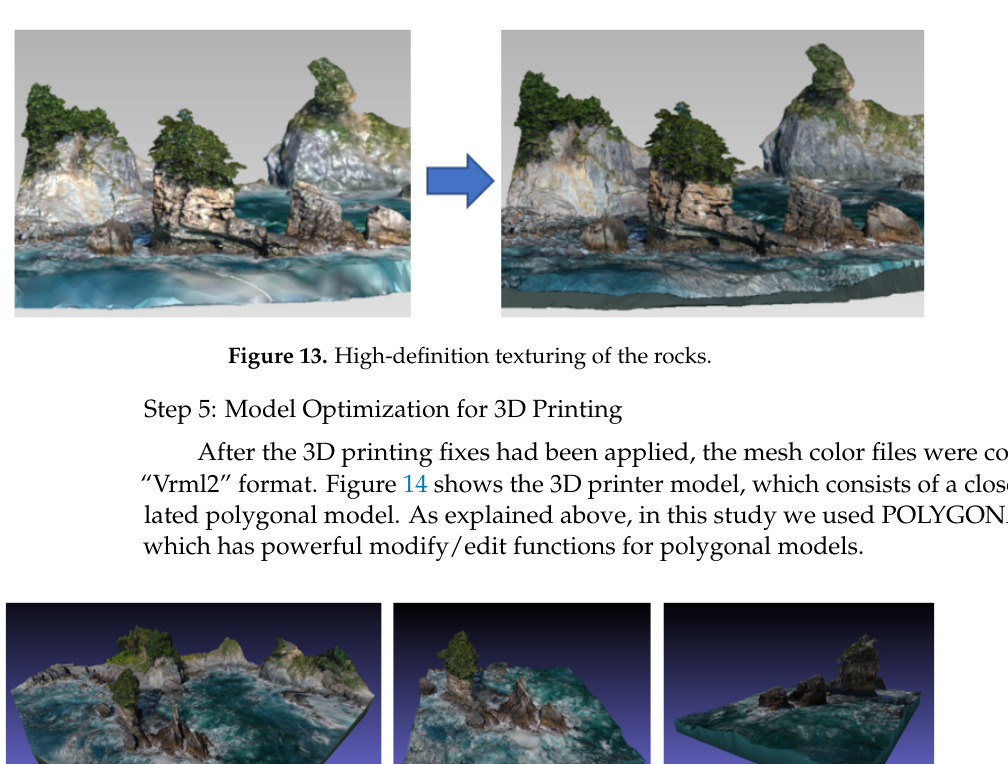
Figure 13. High-definition texturing of the rocks.